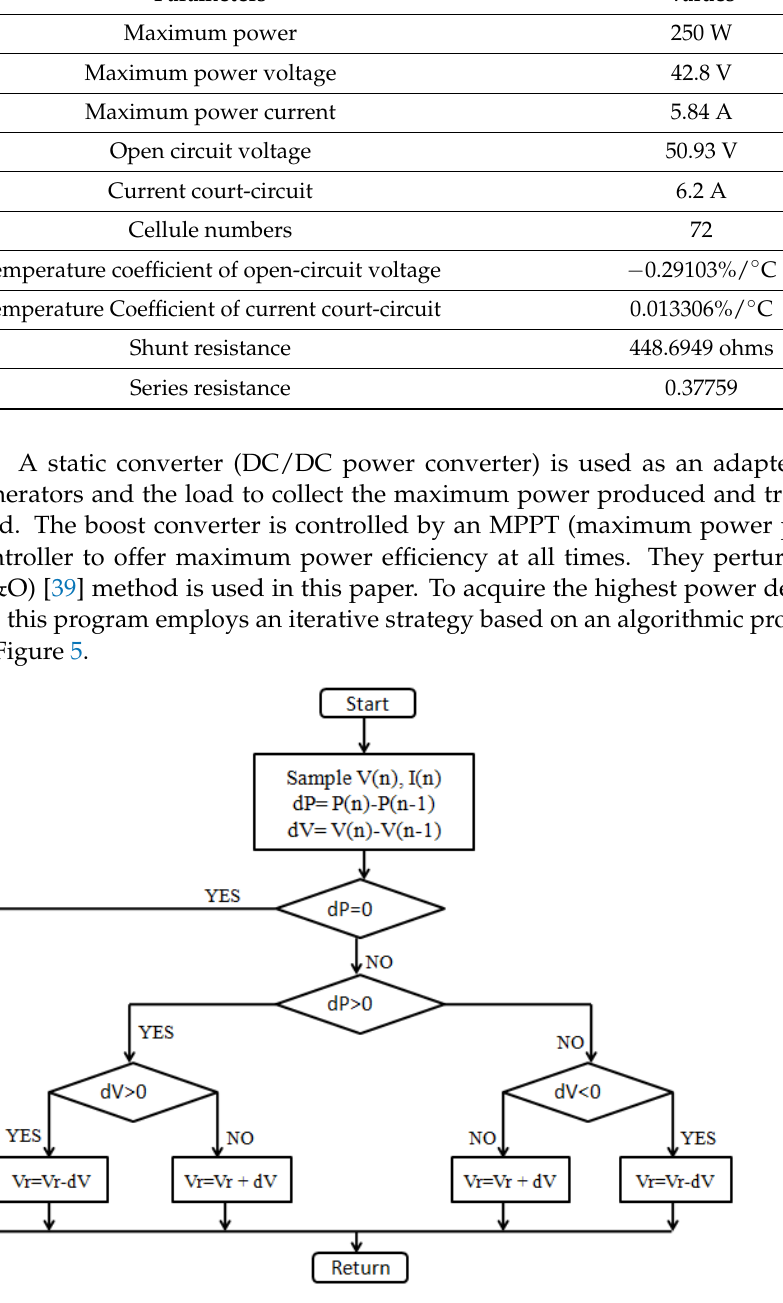
Table 2. Characteristics of (Sun Power SPR-250NX-BLK-D) PV model.